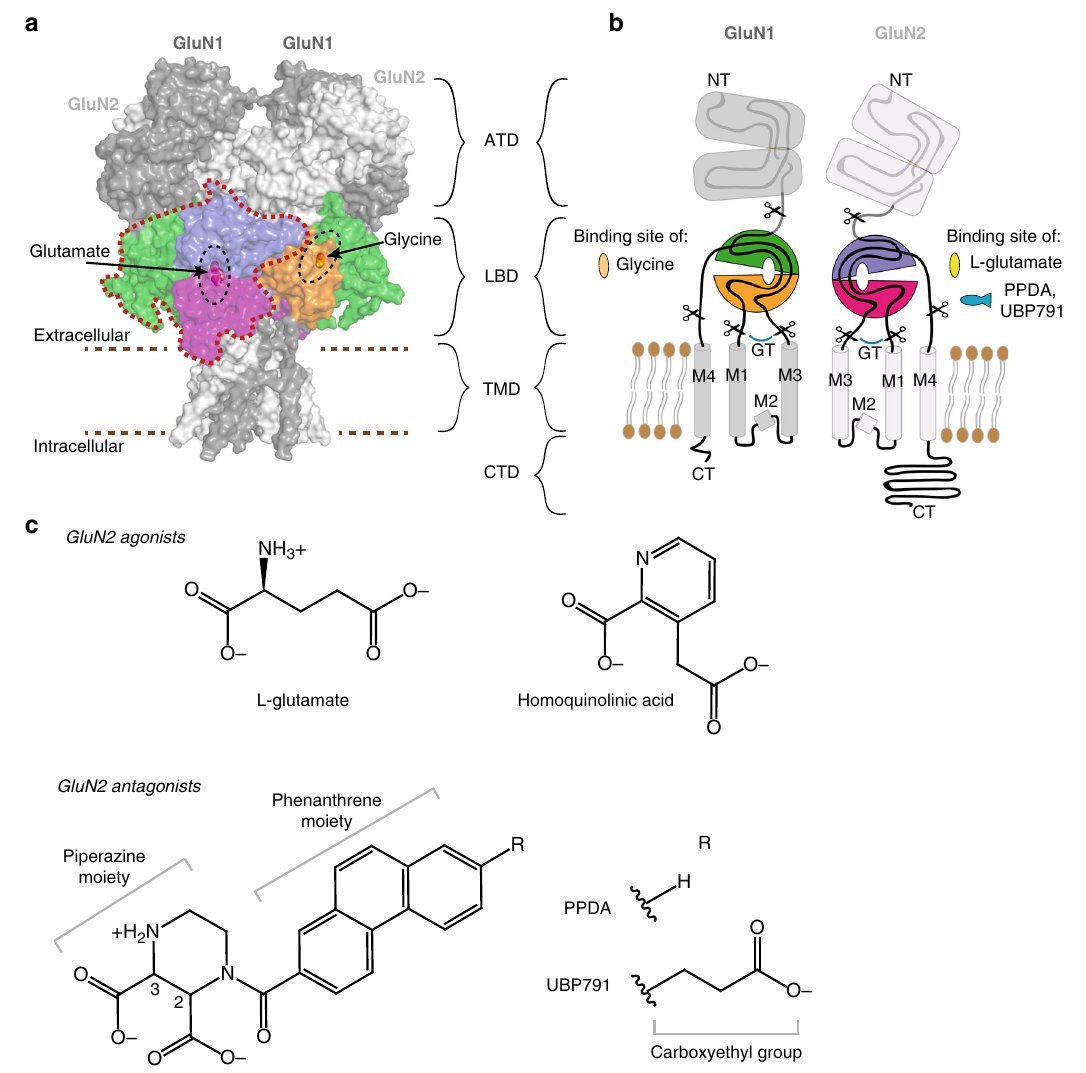
Fig. 1 NMDAR domain organization and ligands. a GluN1/GluN2 form tetrameric receptors with two GluN1 (dark gray) and two GluN2 (light gray) subunits. Each subunit has an ATD, LBD, TMD, and CTD domain (CTD not included). The LBD layer contains a dimer of GluN1 – GluN2 heterodimers, one of which is highlighted by a surrounding red dashed line. The GluN1 upper lobe (D1) and lower lobe (D2) are colored in green and orange, and the GluN2 D1 and D2 in purple and magenta. The surface presentation is produced from the PDB structure 4PE5. b Schematic representation of GluN1 and GluN2 subunits. Glycine, L -glutamate, and competitive antagonists bind in the LBD clefts. The modular build of the subunits allows isolation of the GluN1 and GluN2A LBDs by replacing the M1 – M3 transmembrane sequence with a Gly-Thr dipeptide linker. Color coding as in ( a ). c Chemical structures of GluN2 agonists L-glutamate and homoquinolinic acid and antagonists PPDA and UBP791 at pH ~7. PPDA and UBP791 are cis -racemic mixtures of (2 S ,3 R )- and (2 R ,3 S